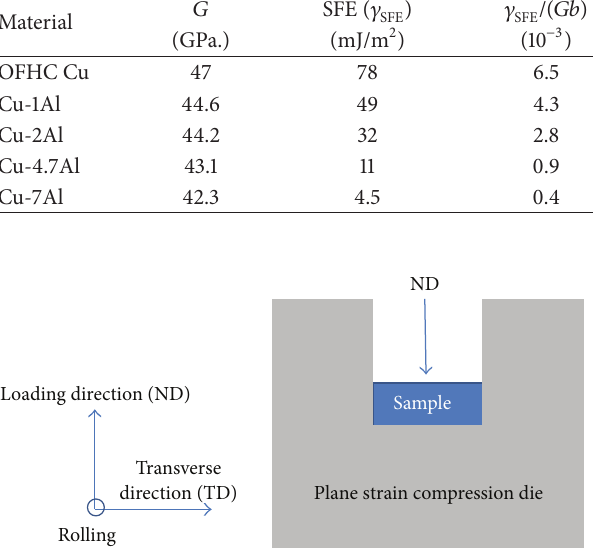
), and nor- SFE /( 𝐺𝑏 ), where 𝑏 is the magnitude of SFE